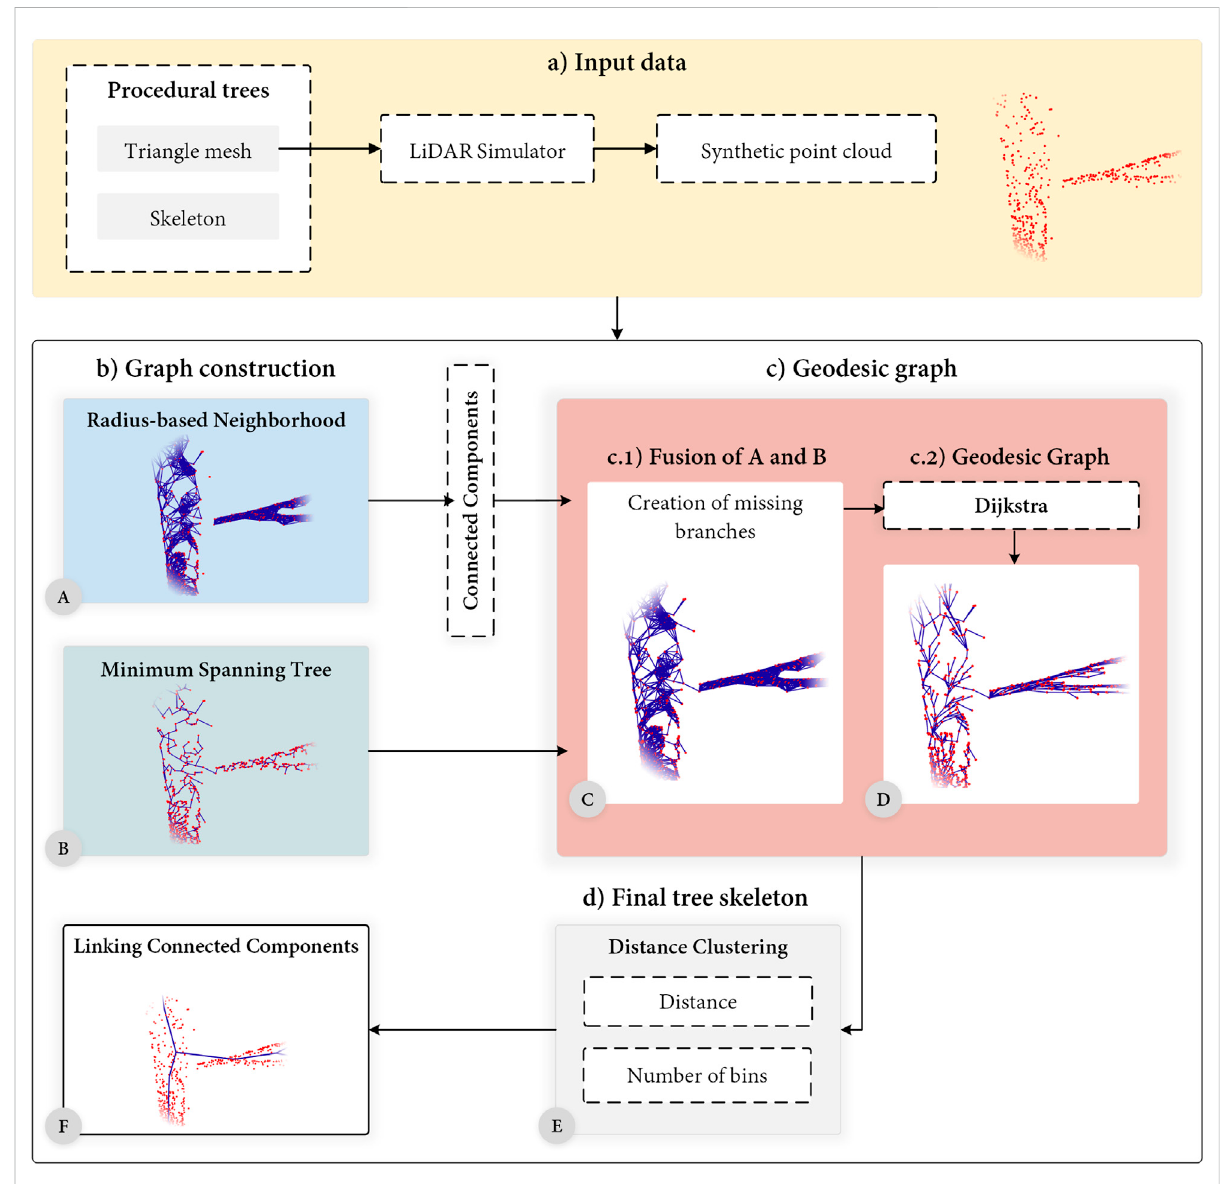
FIGURE 3 Overview of our methodology involving four main steps: (A) the generation of synthetic LiDAR data from the scanning of the 3D procedural trees, (B) thestagesaimedattheconstructionofthestartinggraphs, (C) thefusionandre fi nementmethodsbasedonthegeodeticgraph,and (D) the reduction of the previous results to generate the fi nal